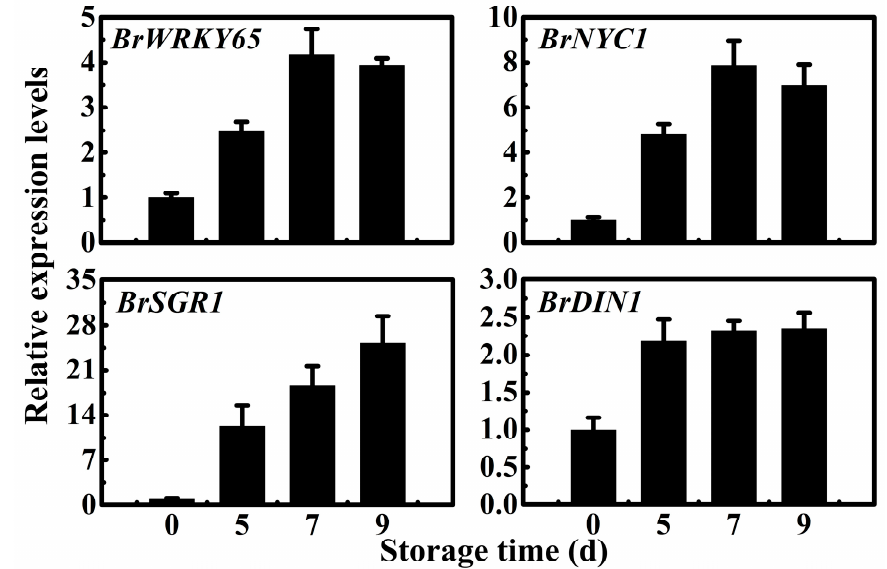
Figure 4. Expression patterns of BrWRKY65 , BrNYC1 , BrSGR1 , and BrDIN1 during Chinese flowering cabbage postharvest leaf senescence. Transcript levels of each gene at 0 d of storage were set as 1. Data represents the mean ± S.E. of three biological replicates.